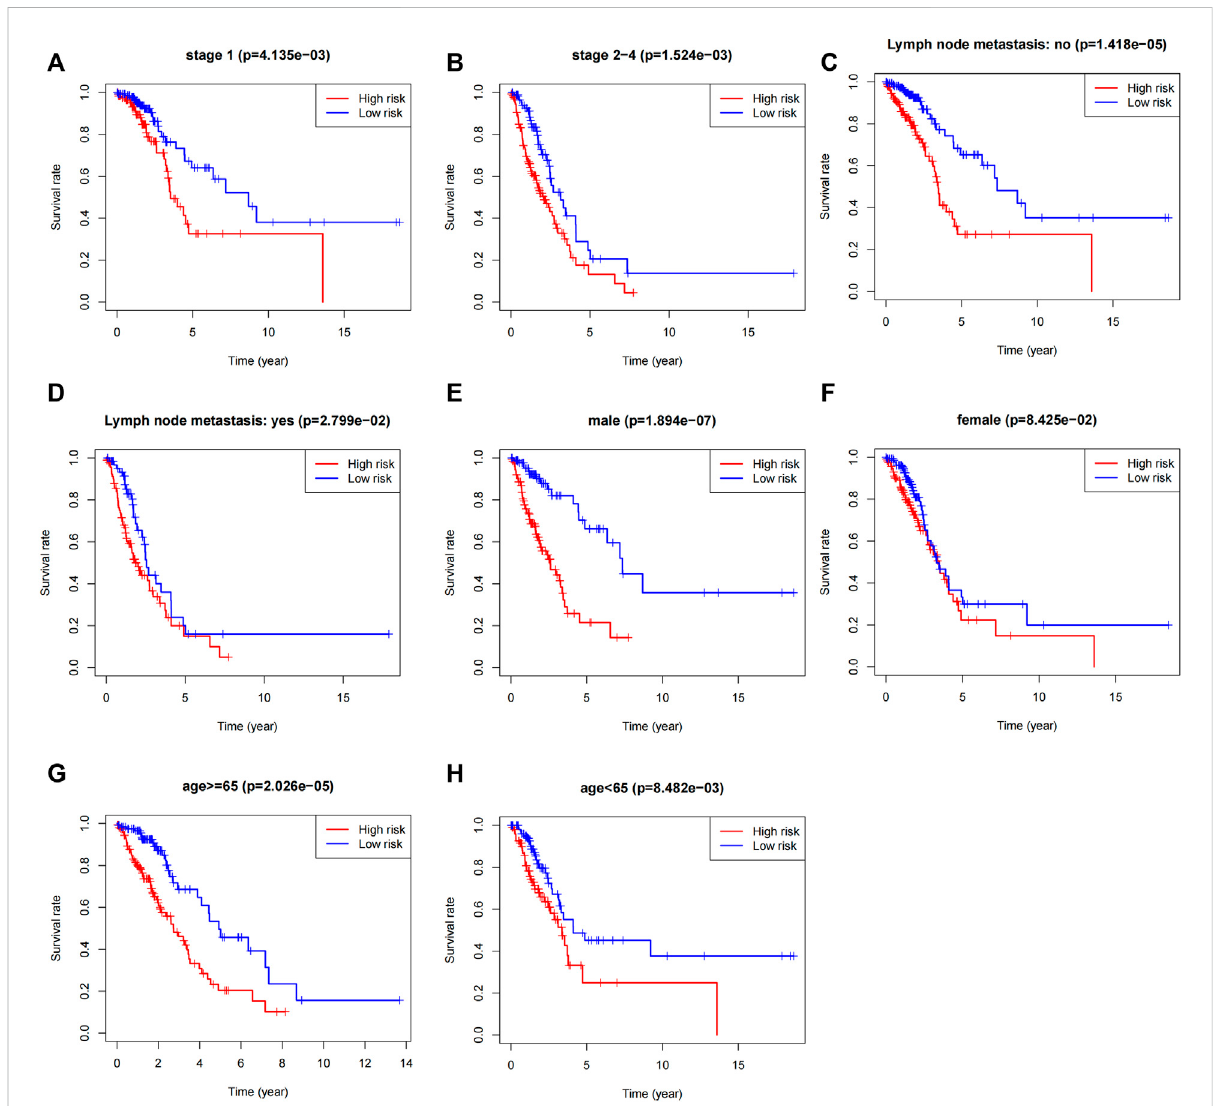
FIGURE 5 Strati fi ed analysis of the 5-lncRNA signature in LUAD patients. (A) Kaplan-Meier analysis of patients in the stage I subgroup, (B) stage Ⅱ – IV subgroup, (C) without lymph node metastasis subgroup, (D) with lymph node metastasis subgroup, (E) male subgroup, (F) female subgroup, (G) age ≥ 65 yearssubgroups,and (H) age < 65